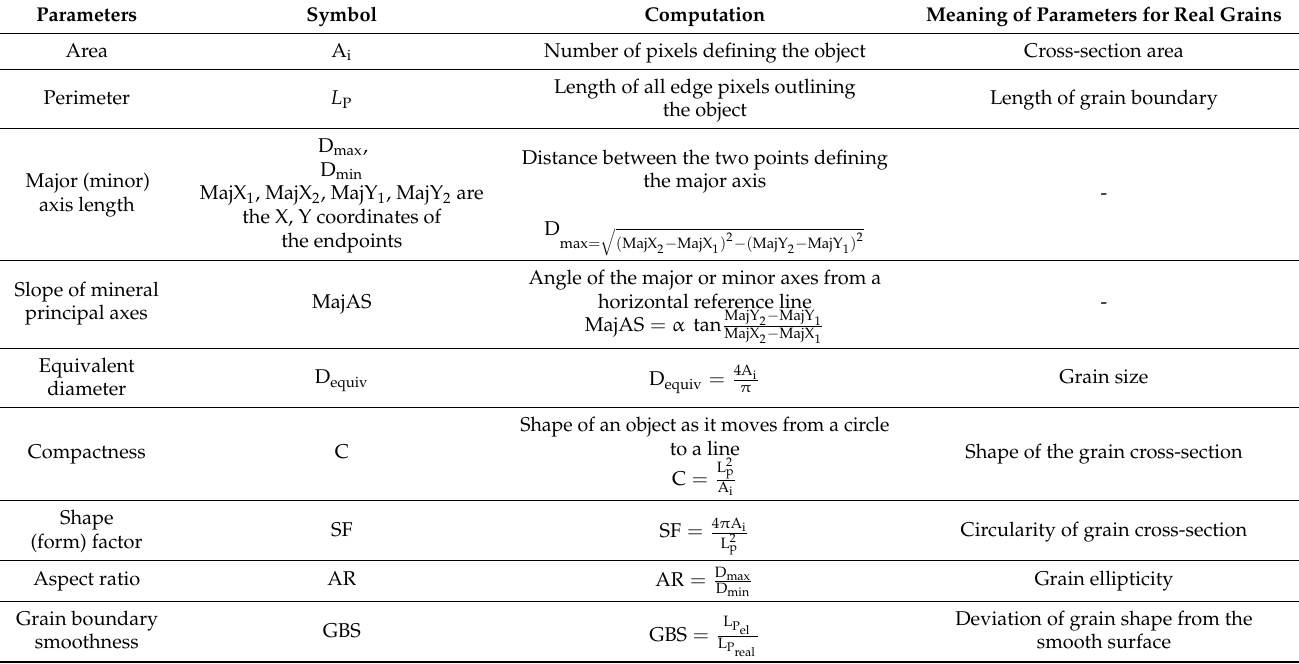
Table 4. Summary of the basic microstructural parameters measured by the petrographic image analysis of thin sections (Adapted from [6,27]).